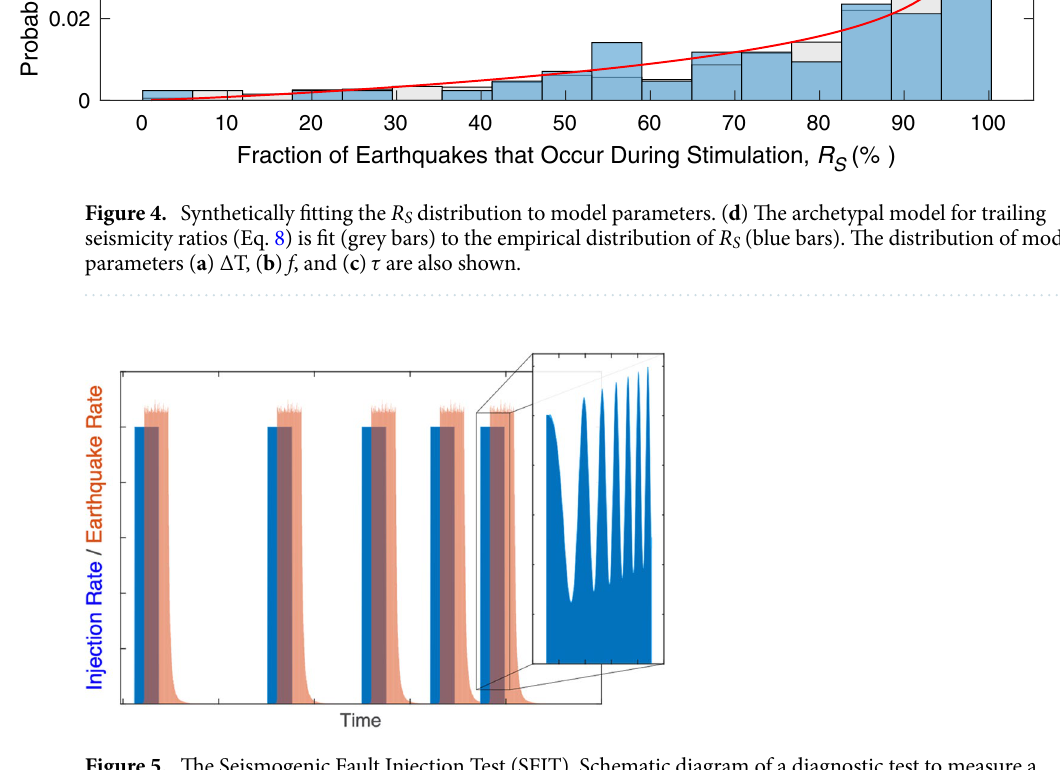
Figure 5. The Seismogenic Fault Injection Test (SFIT). Schematic diagram of a diagnostic test to measure a fault’s seismogneic response through parameters such as Σ , b , ΔT, and τ (or c and p ). Repeated injection tests (at non-periodic intervals) are performed to verify the accuracy of measurements. Inset diagram shows how individual tests could be ‘chirped’ in their injection rate to better constrain